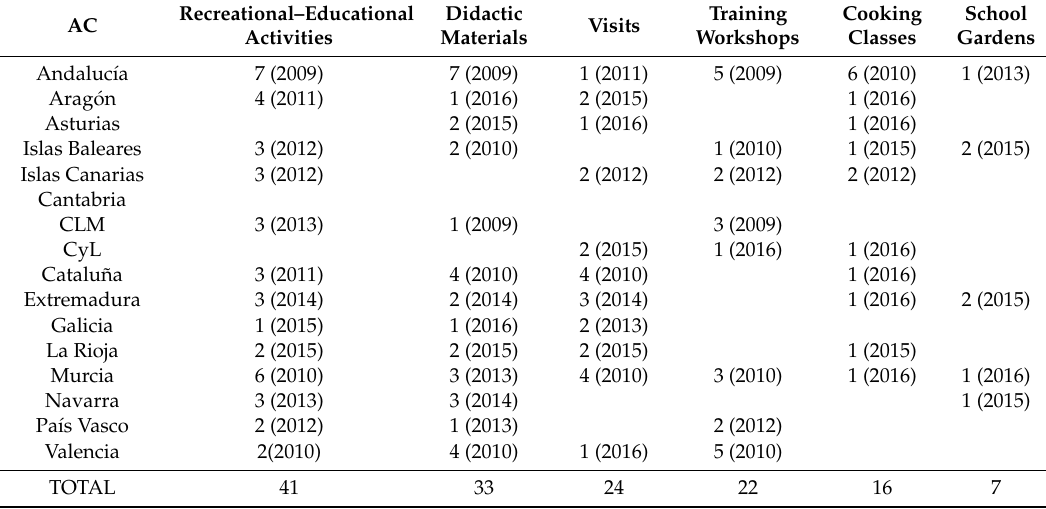
Table 3. Education activities accompanying the School Fruit and Vegetables Scheme for each Table3. EducationactivitiesaccompanyingtheSchoolFruitandVegetablesSchemeforeachautonomous autonomous community (2009–2017), number of times (first year). community (2009–2017), number of times (first